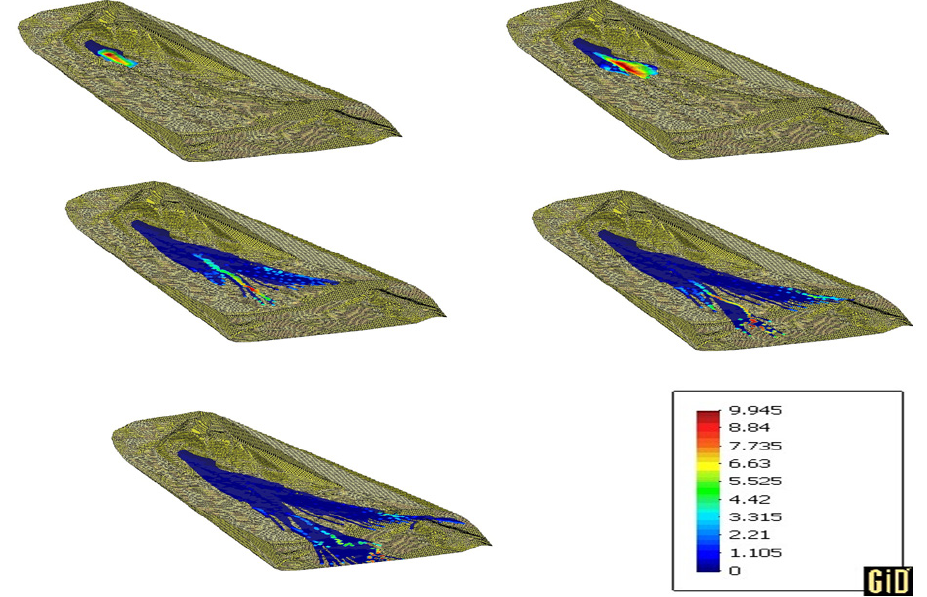
Figure 11. Propagation phase of the Aberfan flowslide with the parameters of Table 2. Colors refer to the height of the soil.